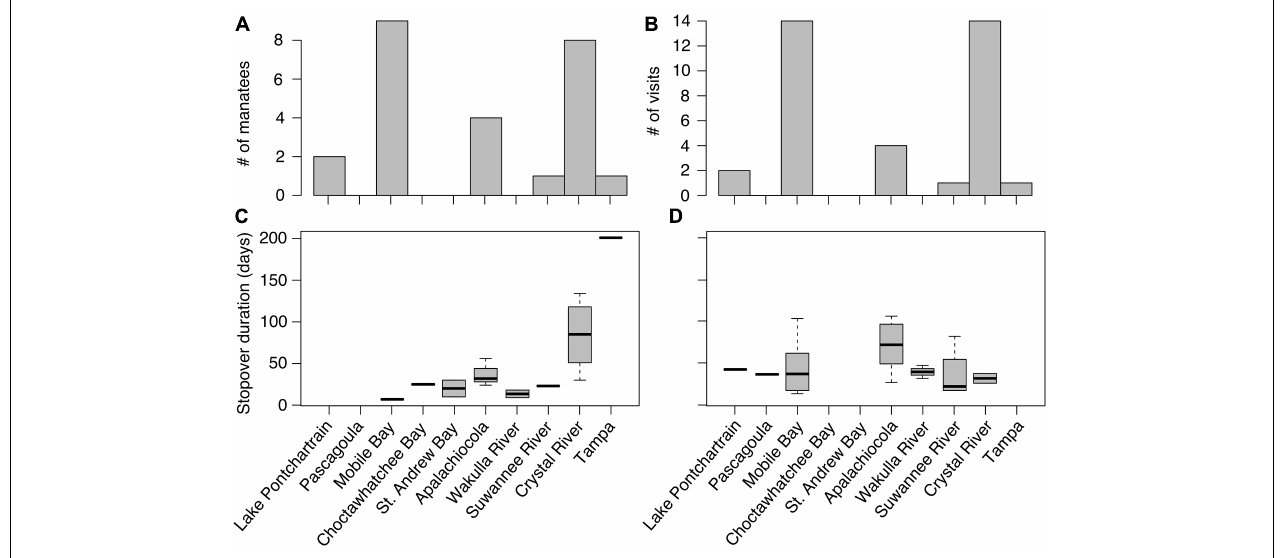
FIGURE 3 | The number of satellite telemetry tagged manatees (A) and visits (B) at terminal locations along manatee migration routes in the northern Gulf of Mexico and peninsular Florida. Stopover duration (days) for satellite tagged manatees at each site during autumn (C) and spring (D) migrations. Tampa was used once as a terminal location and stopover.